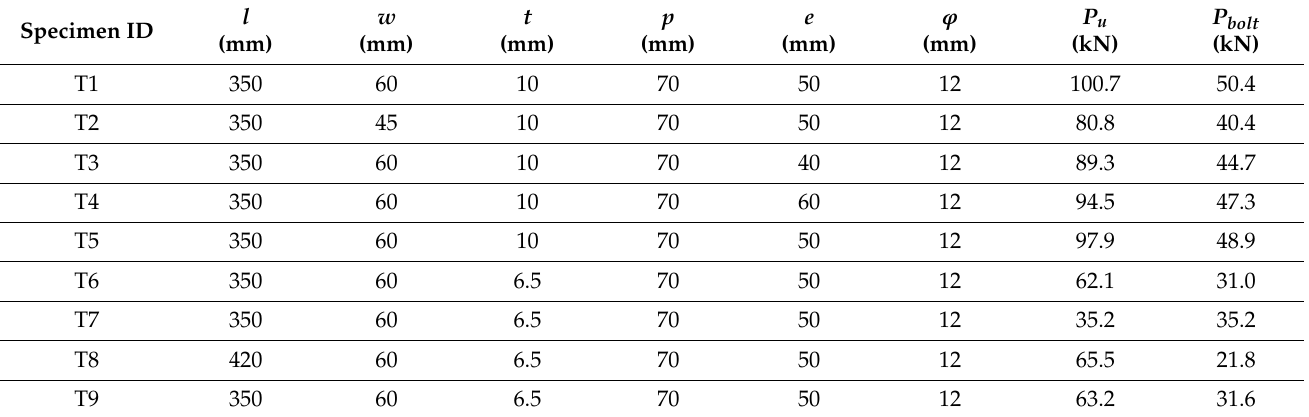
Table 1. Summary of the main parameters of GFRP bolted connection specimens.